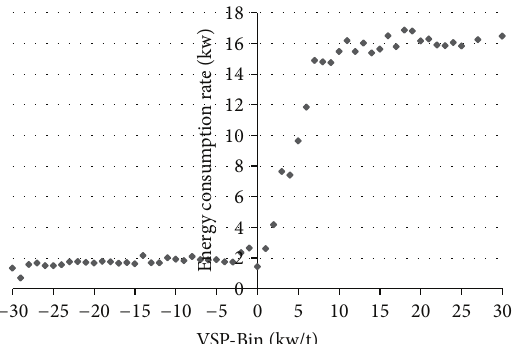
Figure 4: Statistics of the energy consumption rates under different VSP-Bins.